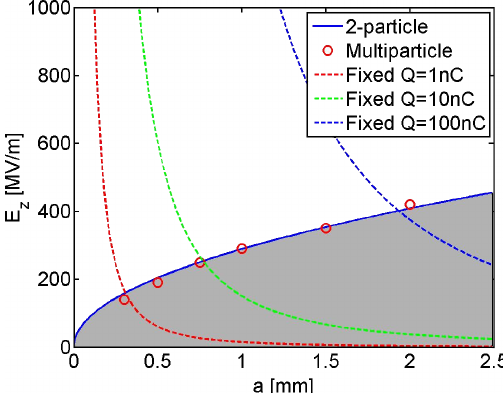
FIG. 5. Maximum bunch charge as a function of the radius in the DWA linac for η ¼ 80 %. The blue line is the two-particle model result and the red circles are the multiparticle beam dynamics simulation results.